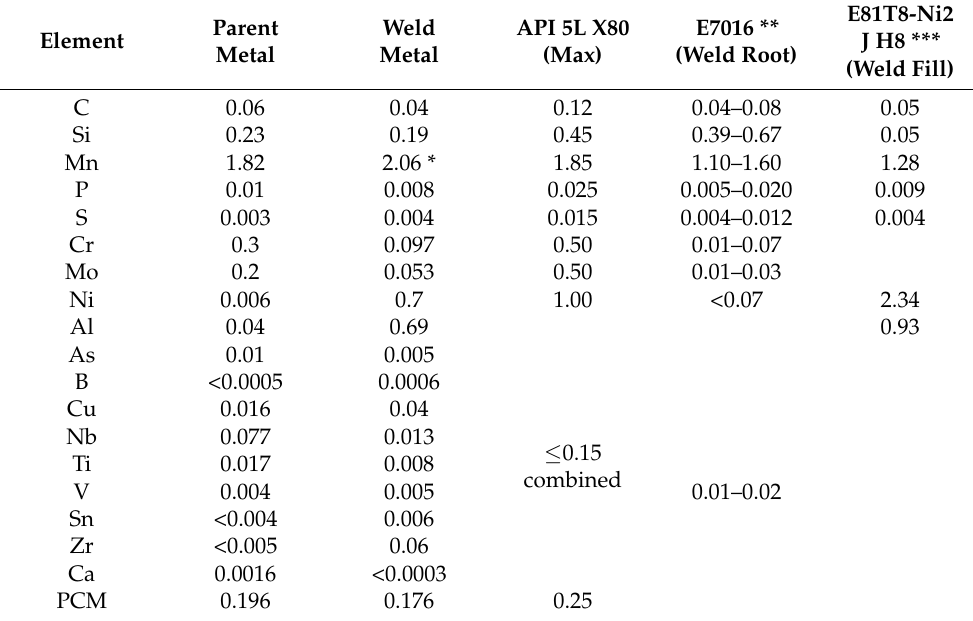
Table 1. Chemical composition of the parent metal and weld metal in the X80 FCAW based on analysis made using optical emission spectroscopy, along with specified compositions for parent and weld filler me. Parent Weld API 5L X80 E7016 ** Element Metal Metal (Max) (Weld Root)